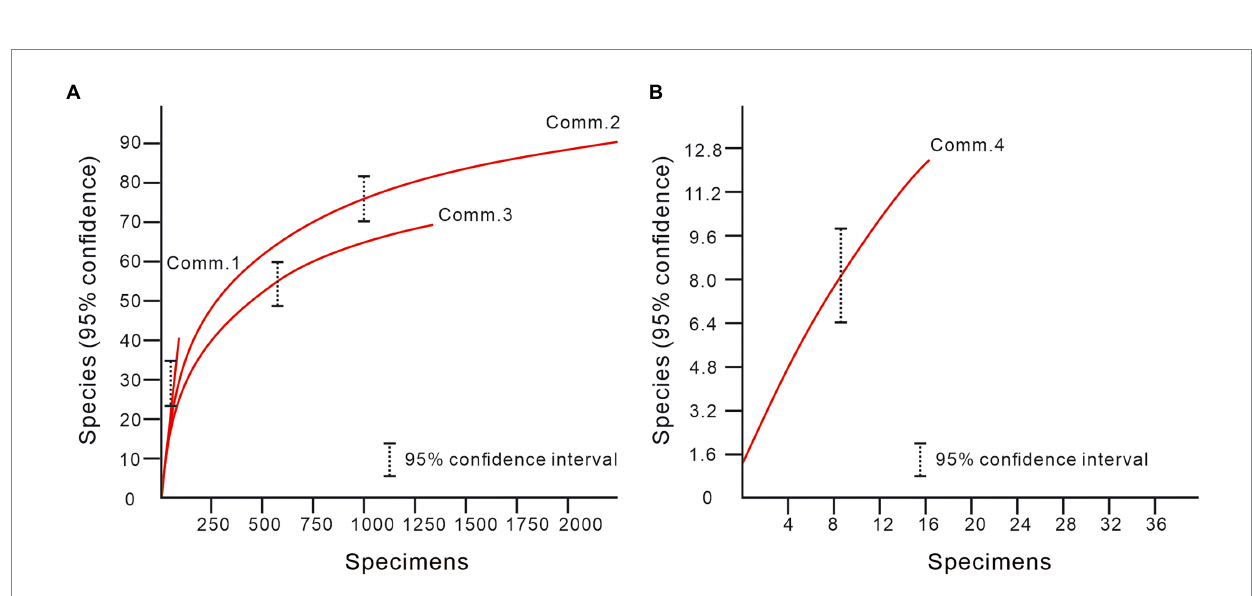
FIGURE 8 Rarefaction curves for four ostracod communities of the Youping section. Comm: